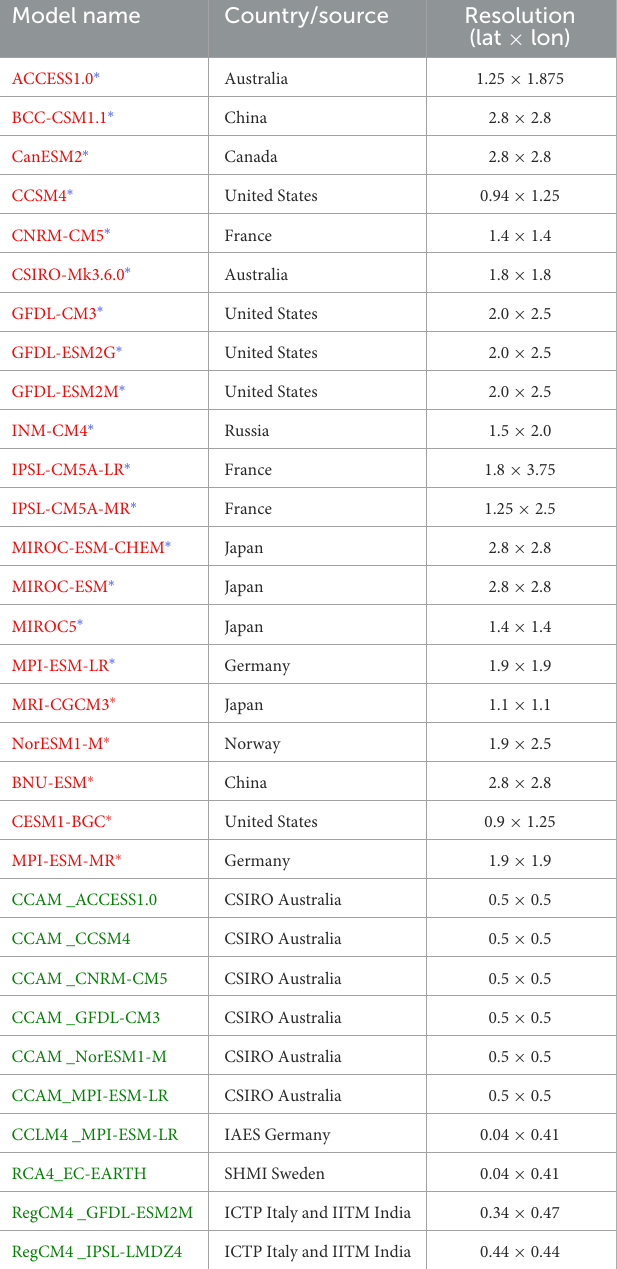
TABLE 1 List of CMIP5 (red color), NEX-GDDP (blue asterisk and blue color), and CORDEX (green color) models used in this study.